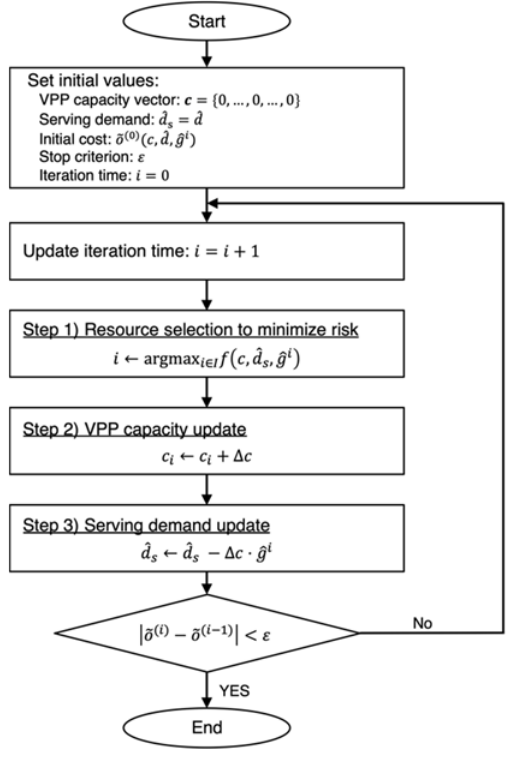
Figure 2. Flow chart of the simple risk-based VPP implementation strategy.